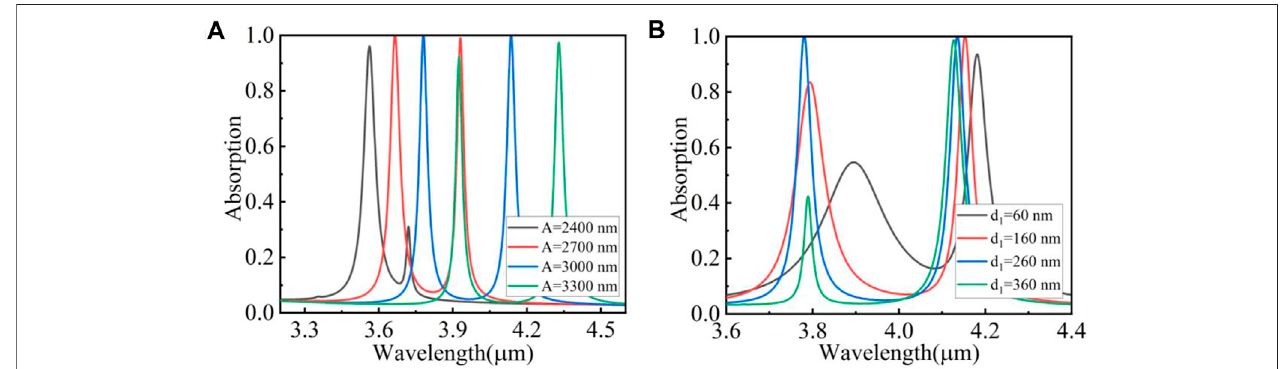
FIGURE 4 | (A) The effect of changing the grating period on the absorption spectrum. (B) The effect of changing the smaller silicon pitch of the grating on the absorption spectrum.